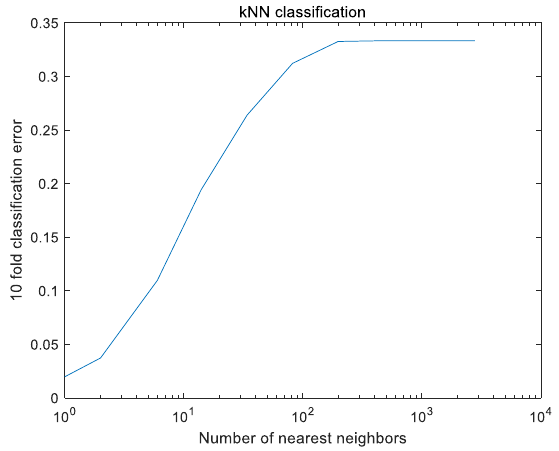
Figure 10. Number of nearest neighbors vs. 10-fold classification error .